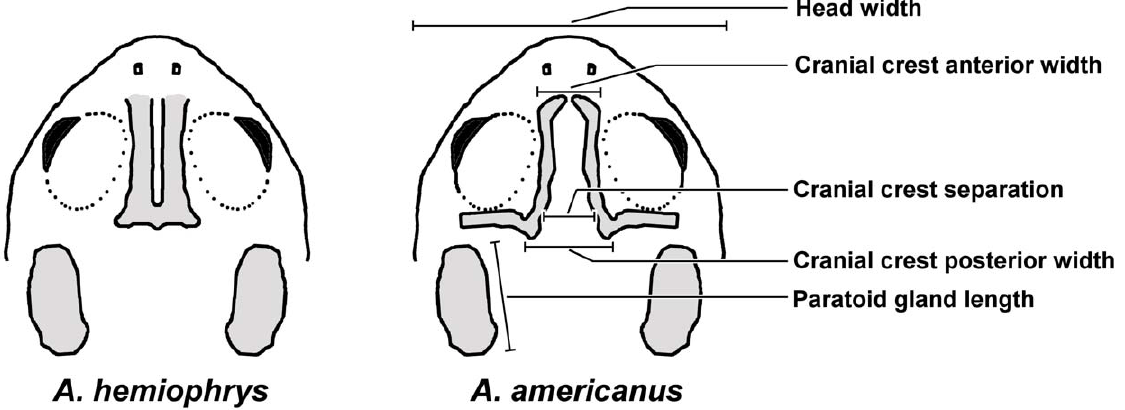
Figure 2. Cranial crests of Canadian Toad, Anaxyrushemiophrys , and American Toad, A . americanus , illustrating the morphological measurements used in this study.